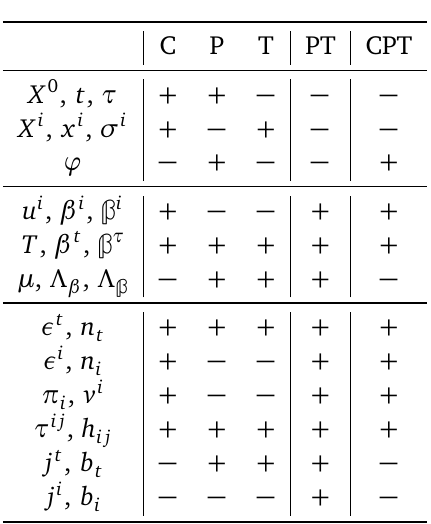
Table 1: Action of parity, time-reversal, and charge conjugation on various quantities in classical hydrodynamics and effective field theory. In the next section we intro- duce Schwinger-Keldysh double copies of various quantities in the effective theory, with labels “1 / 2” or “ r / a ”, which have the same transformation properties as their unlabelled